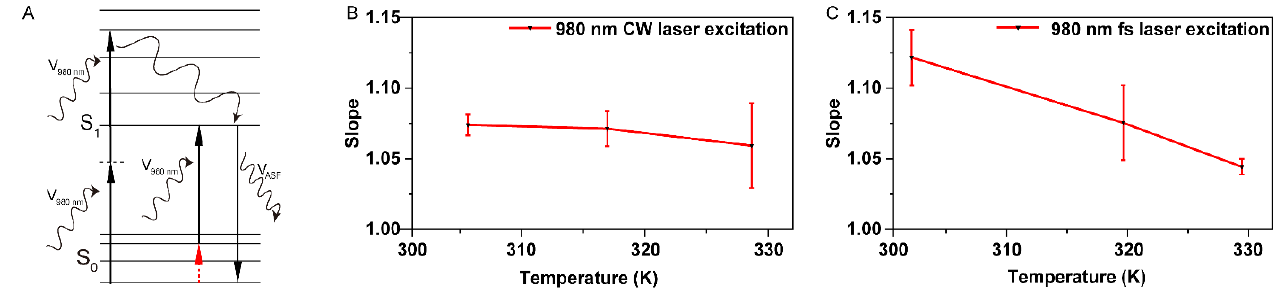
Figure 3. Effect of HBA-induced anti-Stokes fluorescence on nonlinear optics. ( A ) Schematic illustrations of hot-band and two-photon absorption processes of BPN-BBTD dots. The anti-Stokes fluorescence could be produced by both processes. ( B ) The temperature and excitation light power dependence of anti-Stokes fluorescence intensity under the excitation of continuous-wave lasers. ( C ) The temperature and excitation power dependence of anti-Stokes fluorescence intensity under the excitation of femtosecond lasers. Results are presented as mean ± SEM, n = 3.